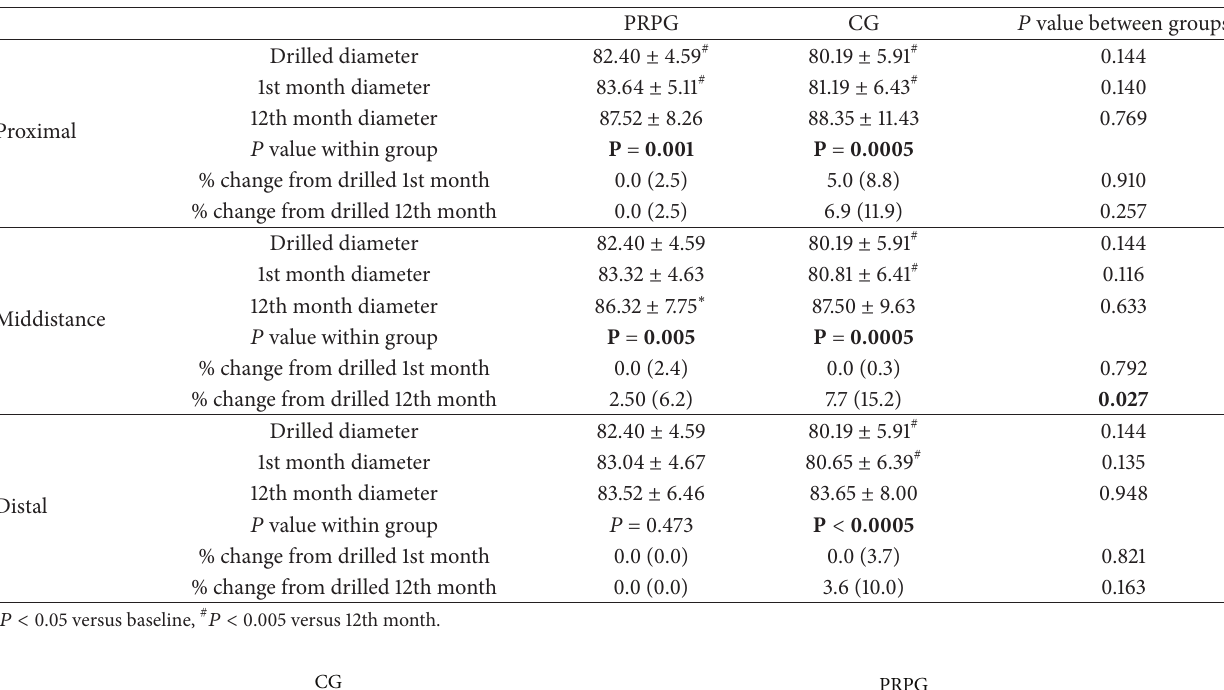
Table 3: Comparison of proximal, middistance, and distal tunnel mean diameters between groups during the observation period.